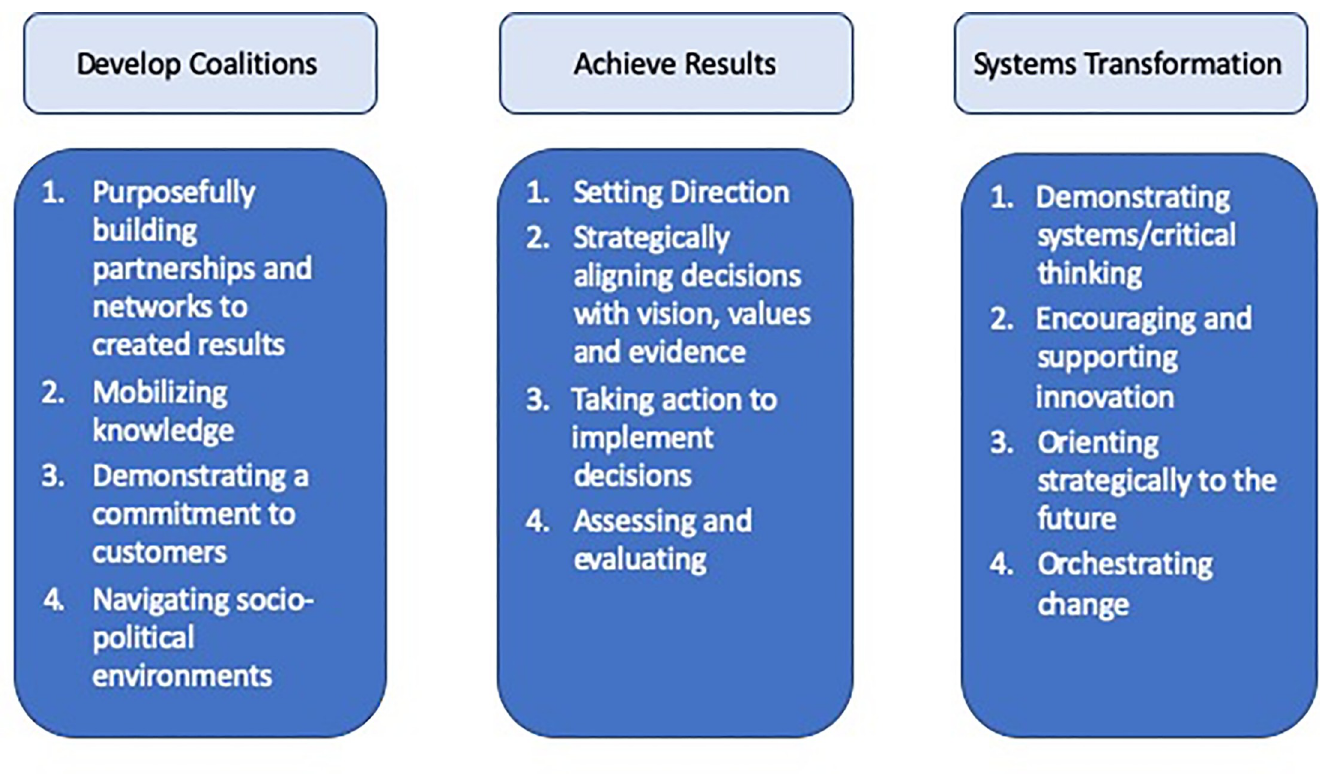
Fig 3. LEADS domains and respective capabilities analyzed 12-14